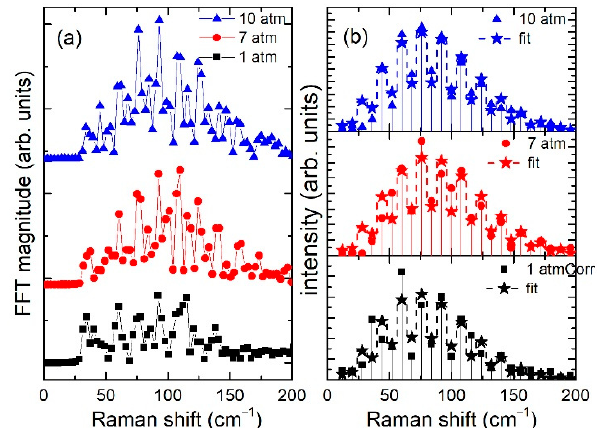
Figure 3. ( a ) Magnitude of the FFT of the ISRS data shown in Figure 2b. ( b ) Raman spectra of N 2 samples at different pressures obtained by division of the FFT data shown in ( a ) by the Raman shift and interpolation on the N 2 rotational lines, together with fits of the line intensities calculated as described in the